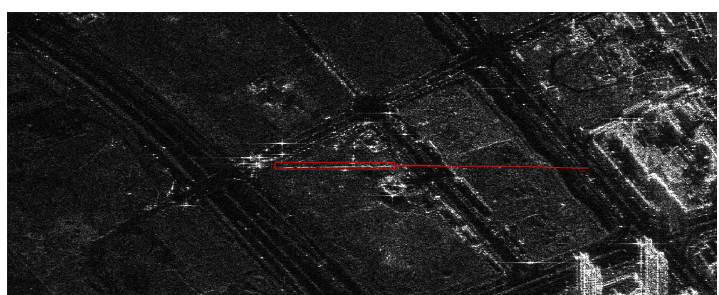
Figure 21. The final tracking result which is generated by superimposing track’s information on higher resolution subaperture images. The red line denotes the target’s trace, and the red box means its minimal bounding box in the current image.